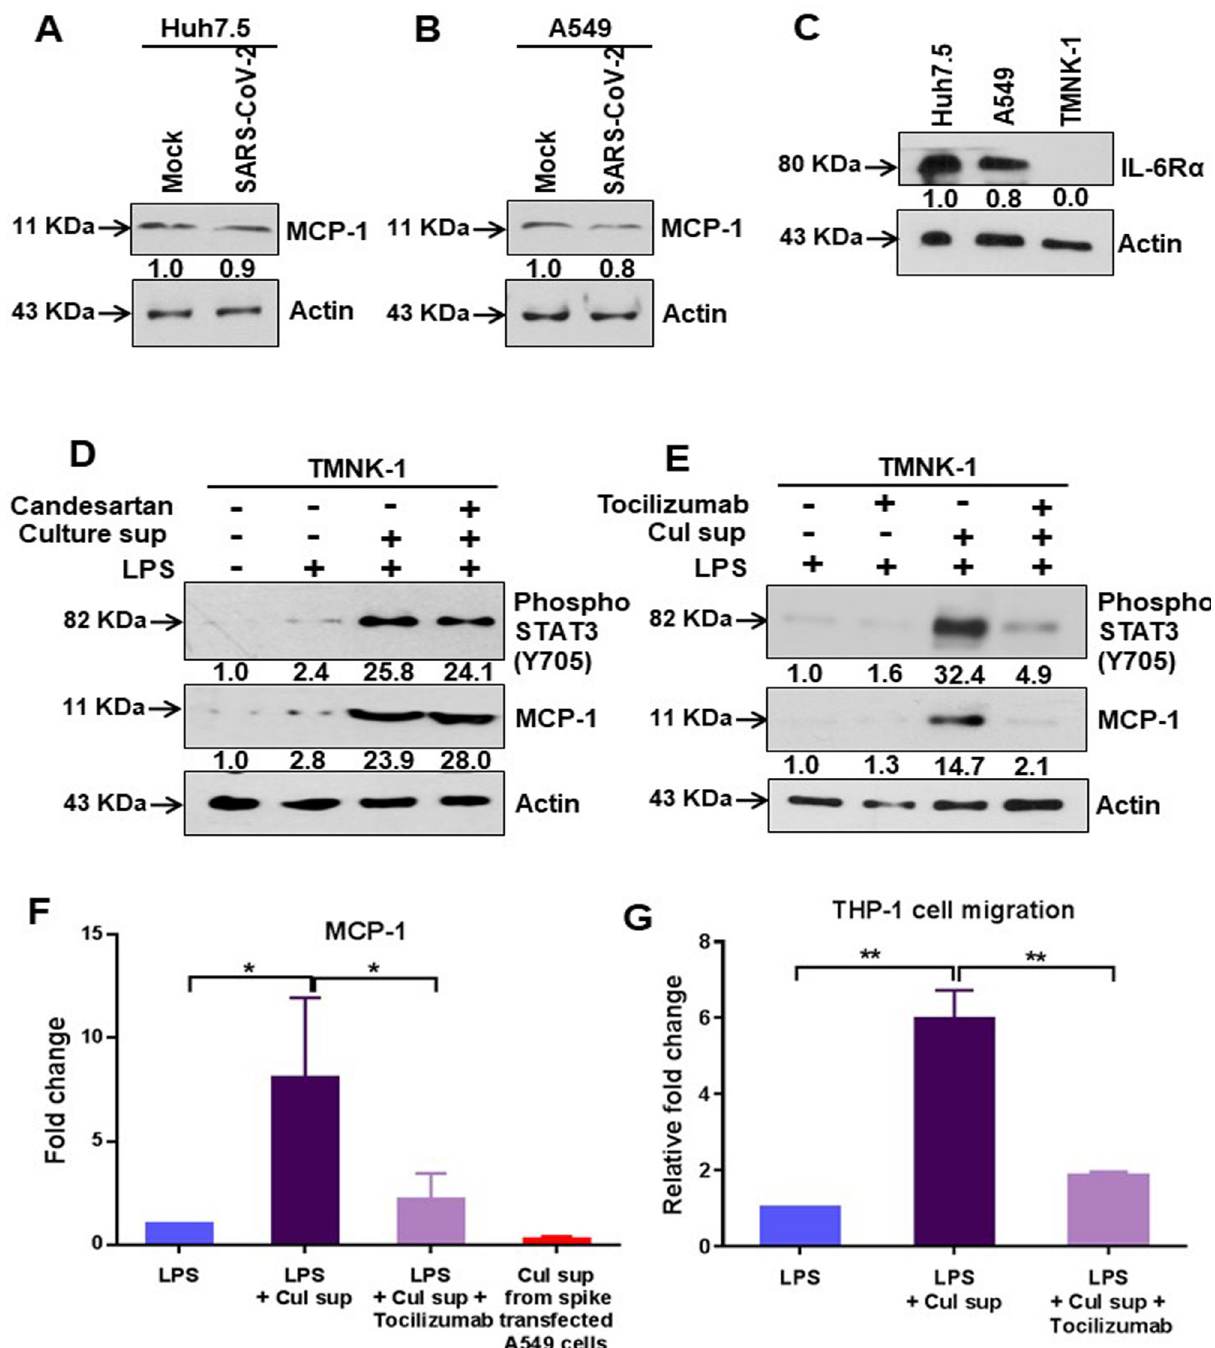
Fig 7. IL-6 trans-signaling induces MCP-1 expression. (A, B) Western blot analysis of MCP-1 expression in Huh7.5 and A549 cell lysates prepared after 48 h of mock-treated or infected with SARS-CoV-2 virus. (C) Western blot analysis for IL-6R α expression in Huh7.5, A549, or TMNK-1 cell lysates. (D) Western blot analysis of phospho-STAT3 (Tyr705) and MCP-1 expression in TMNK-1 liver endothelial cell lysates prepared after treated with or without culture supernatant from SARS-CoV-2 spike gene expressed A549 cells in presence or absence of Candesartan cilexetil and LPS. (E) Western blot analysis for phospho-STAT3 (Tyr705) and MCP-1 expression status in TMNK-1 liver endothelial cell lysates prepared after treatment with LPS and culture supernatant from SARS-CoV-2 spike gene expressed A549 cells in the presence or absence of Tocilizumab. Expression level of actin in each lane from the same gel is shown as a total protein load for comparison. (F) The extra-cellular level of MCP-1 was measured by ELISA in culture supernatant of TMNK-1 cells after treatment with LPS alone or together with culture supernatant from SARS-CoV-2 spike gene expressing A549 cells in the presence or absence of Tocilizumab. The MCP-1 expression level in the culture supernatant from SARS-CoV-2 spike gene expressing A549 cells was